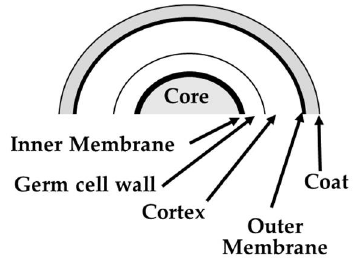
Figure 3. General structure of a bacterial spore.